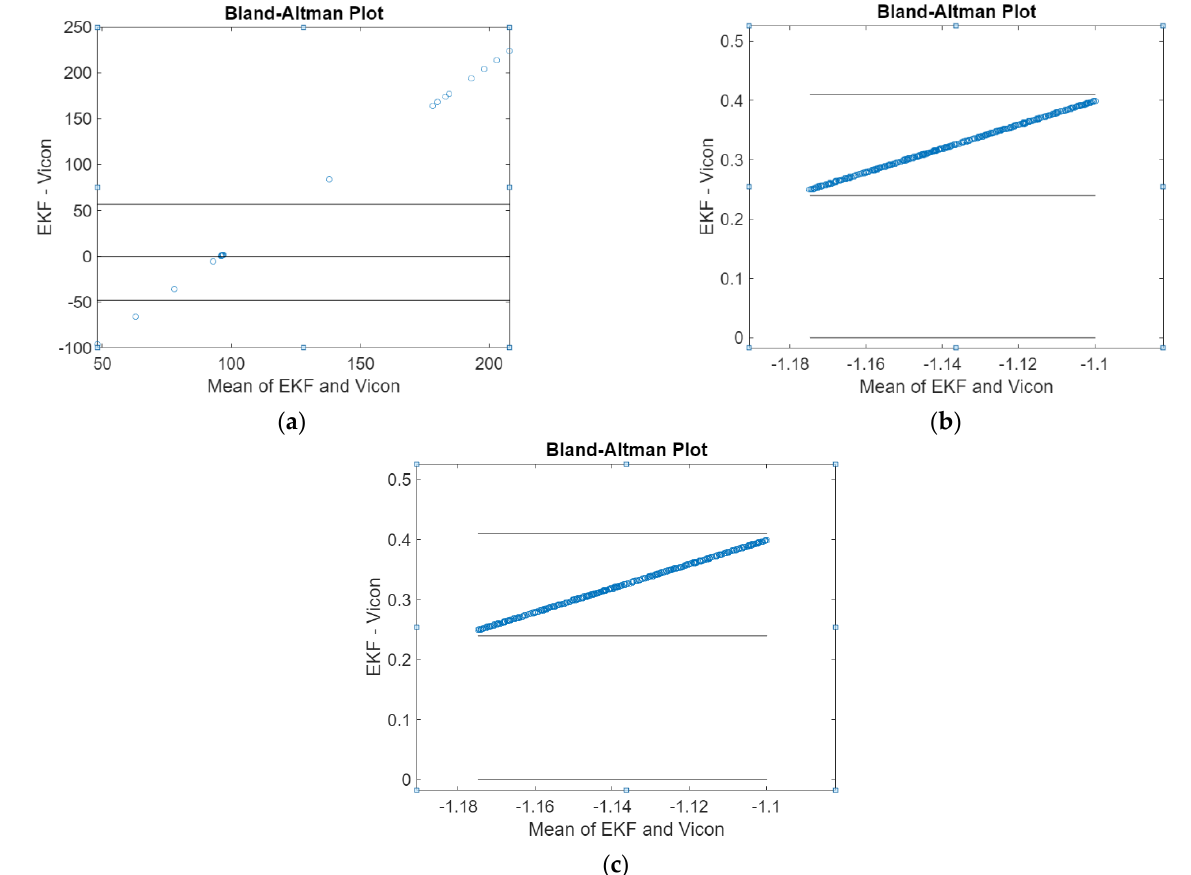
Figure 3. Profile of Euler angles during the fine alignment process (scenario no.1): ( a ) Heading, ( b ) Pitch, and ( c ) Roll.